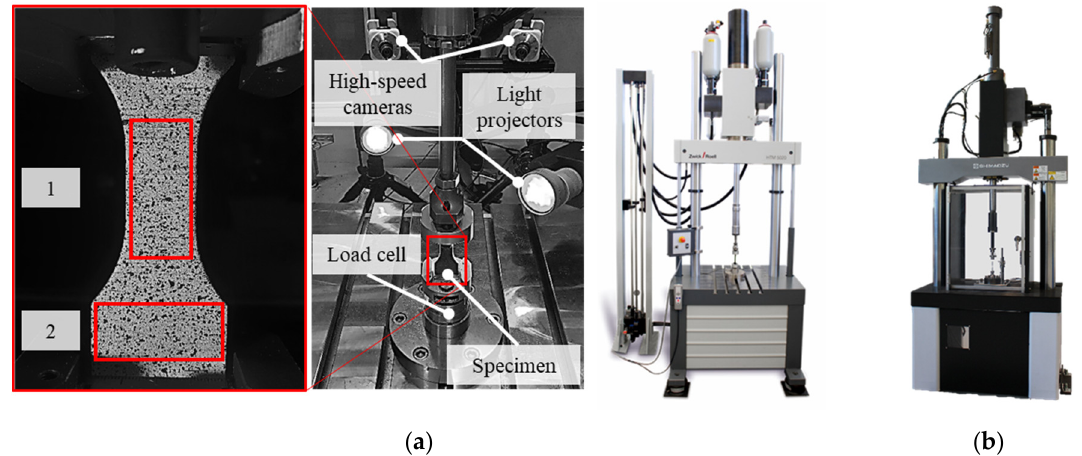
Figure 4. Experimental setup for high-speed tests: ( a ) HTM 5020 for tensile loading; ( b ) HITS-TX 10 for shear loading.